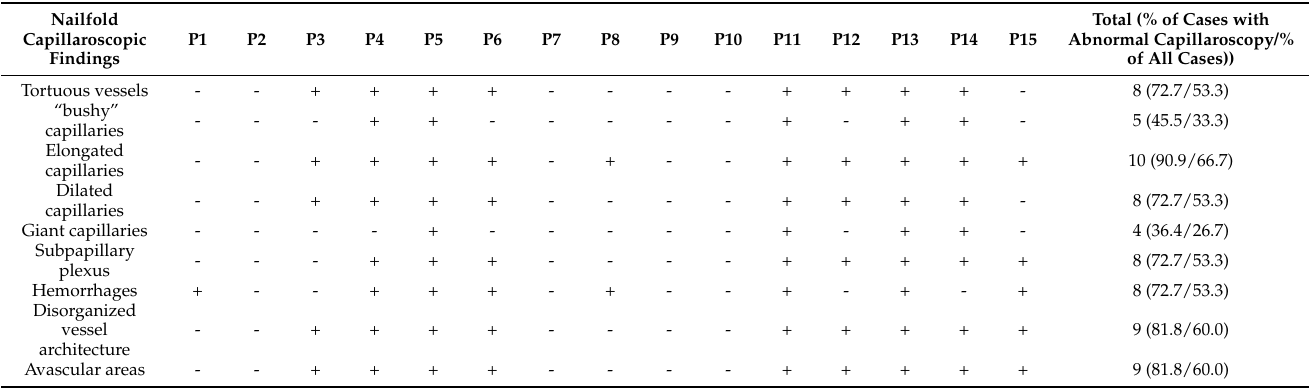
Table 2. Dermoscopic features of the nailfold in patients with dermatomyositis (P1–P15—patient numbers).